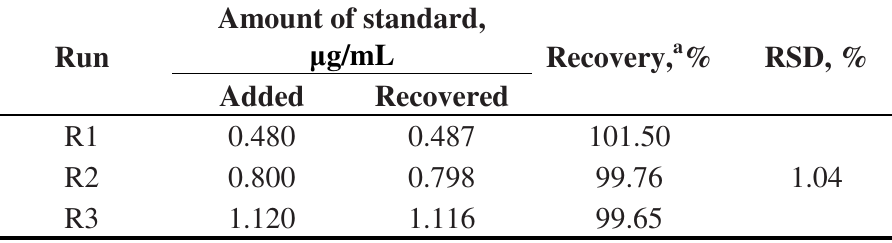
Table 2. Accuracy of the microbiological assay of